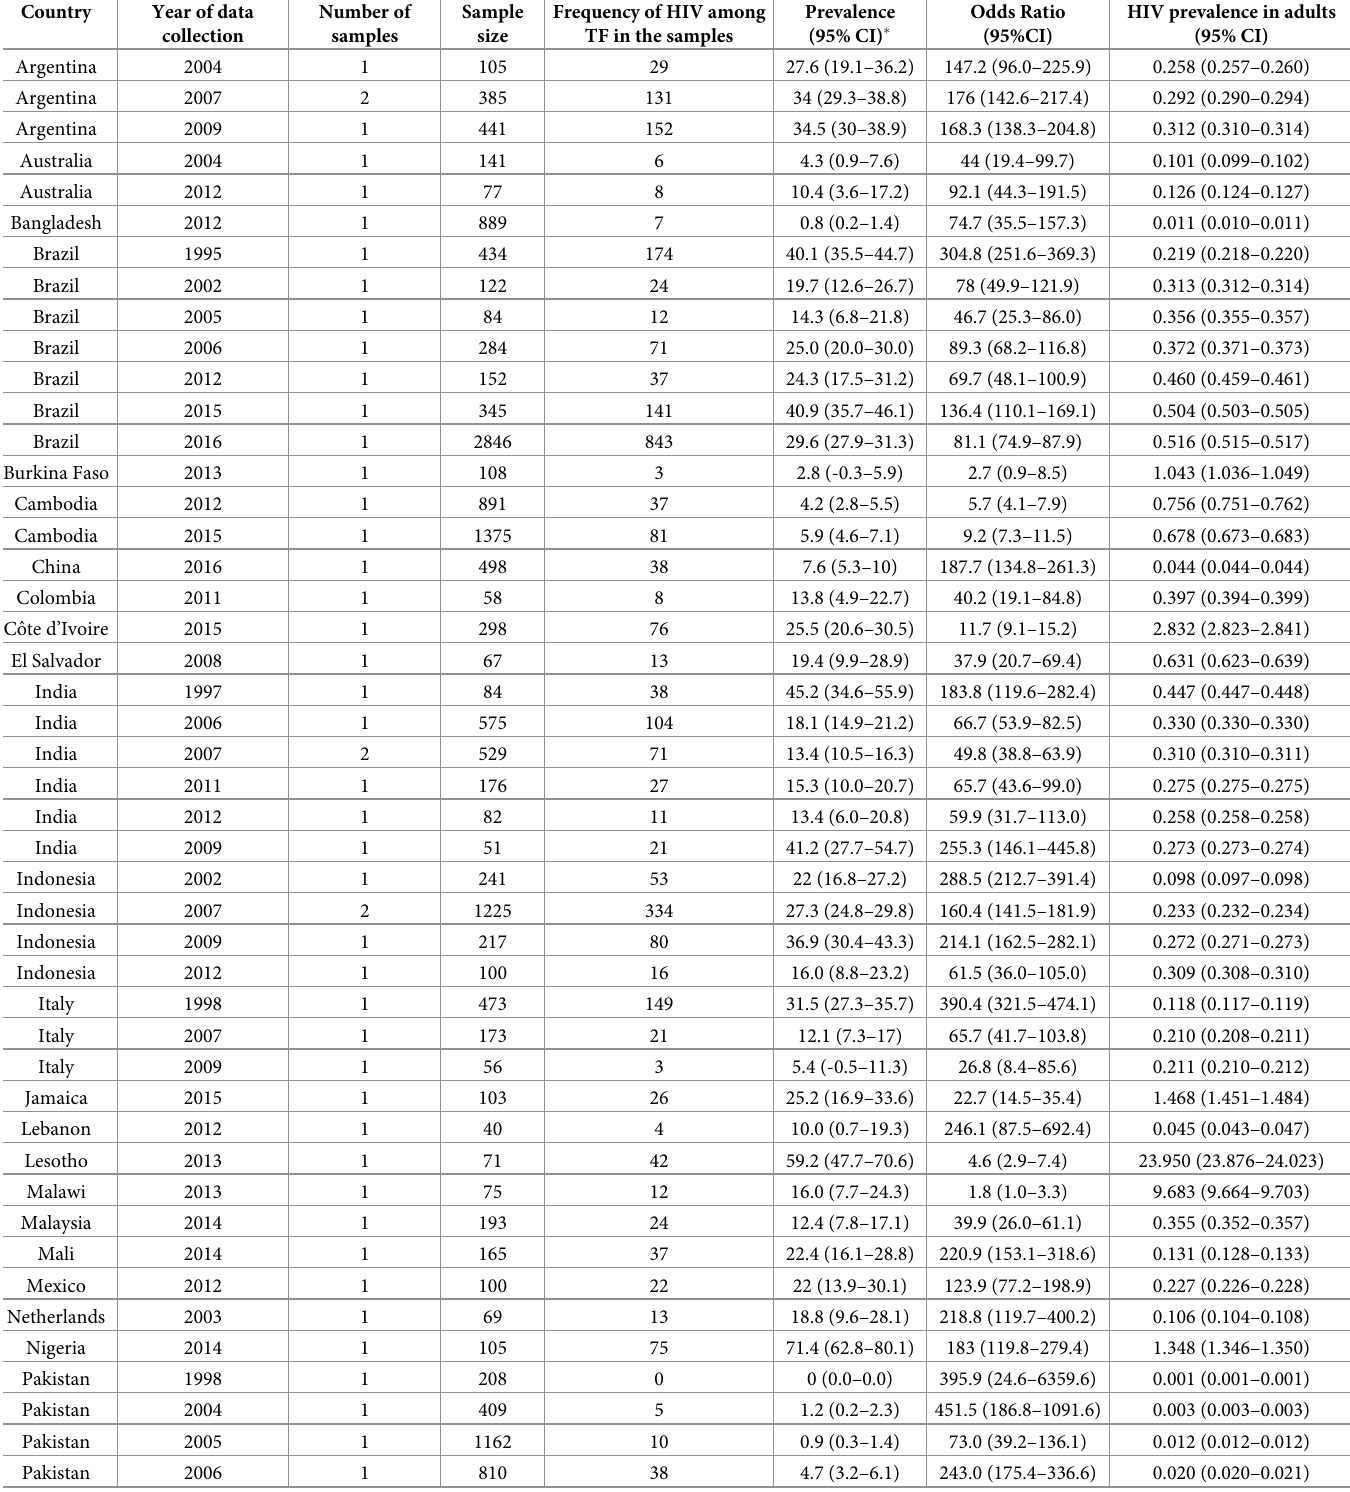
Table 2. Meta-analysis of HIV prevalence in trans feminine individuals compared to all adults (age